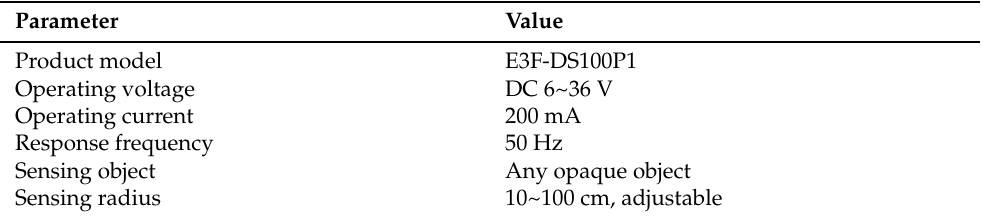
Table 7. The technical parameters for the diffuse reflection photoelectric infrared proximity sensor.